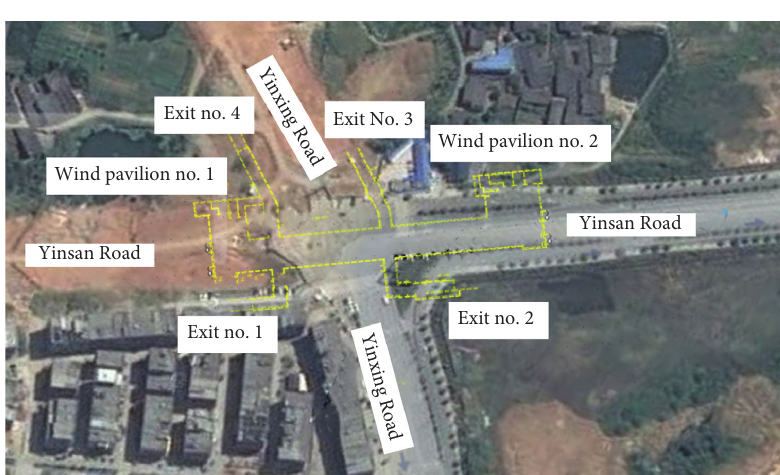
Figure 6: Aerial map of Xiangjiang New Town Station